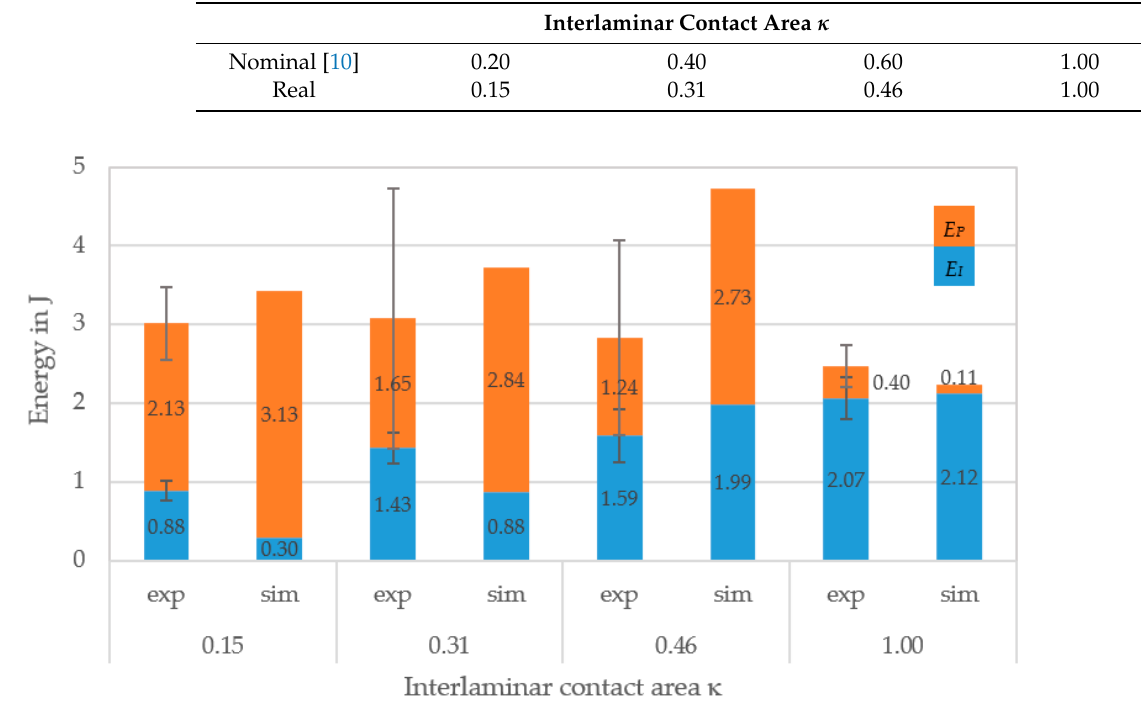
Figure 10. Experimental and numerical initial E I and propagation energy E P in three-point bending test for certain interface modifications κ .